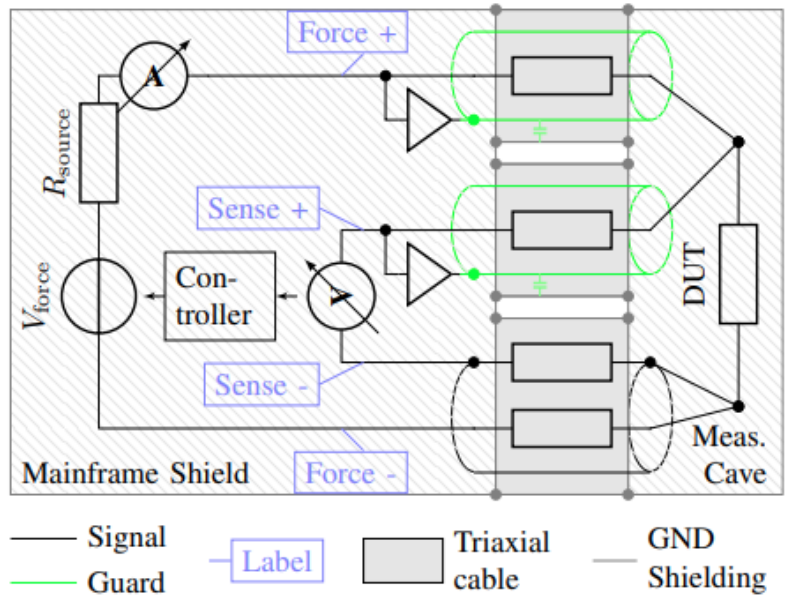
Figure 6. Four-wire measurement configuration involving a Keysight Technologies E5270 8-channel precision